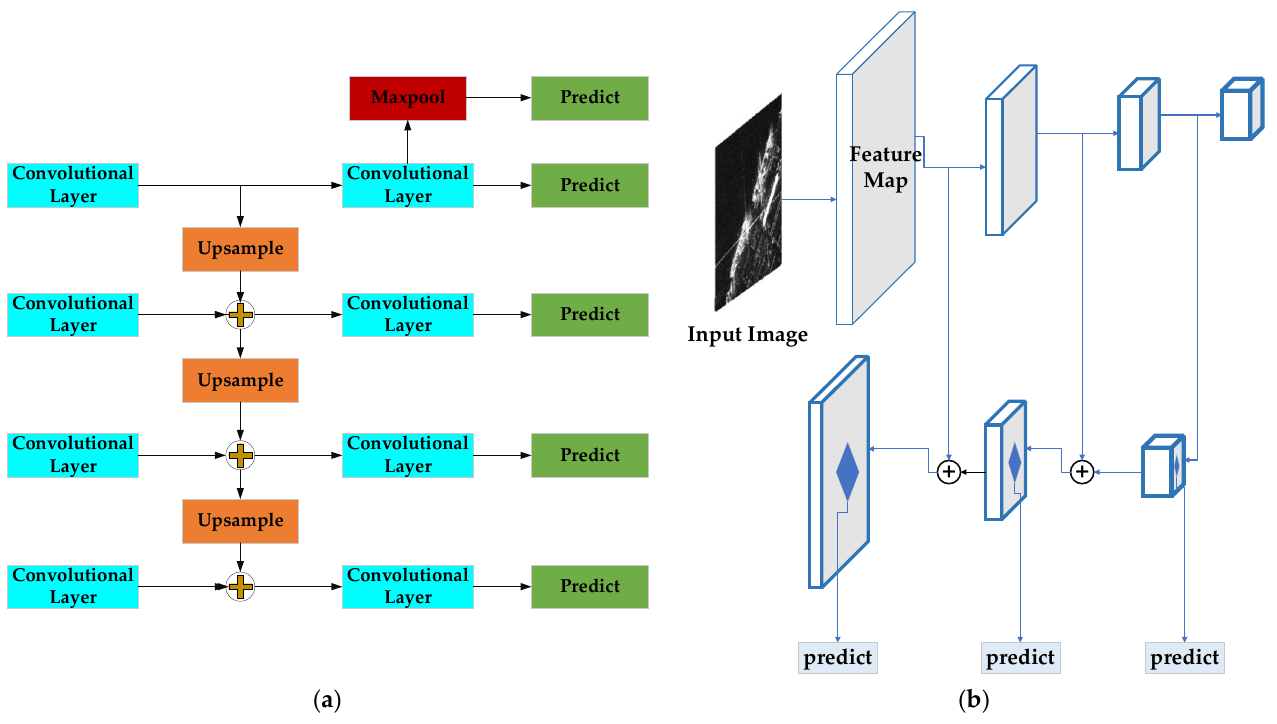
Figure 12. Typical structure of characteristic feature pyramid network. ( a ) A schematic of the FPN, including convolution, upsampling, as well as maxpooling operation, and so on; ( b ) Represents the topology diagram of FPN. In this figure, white squares indicate feature maps, and thicker outlines denote semantically stronger features.